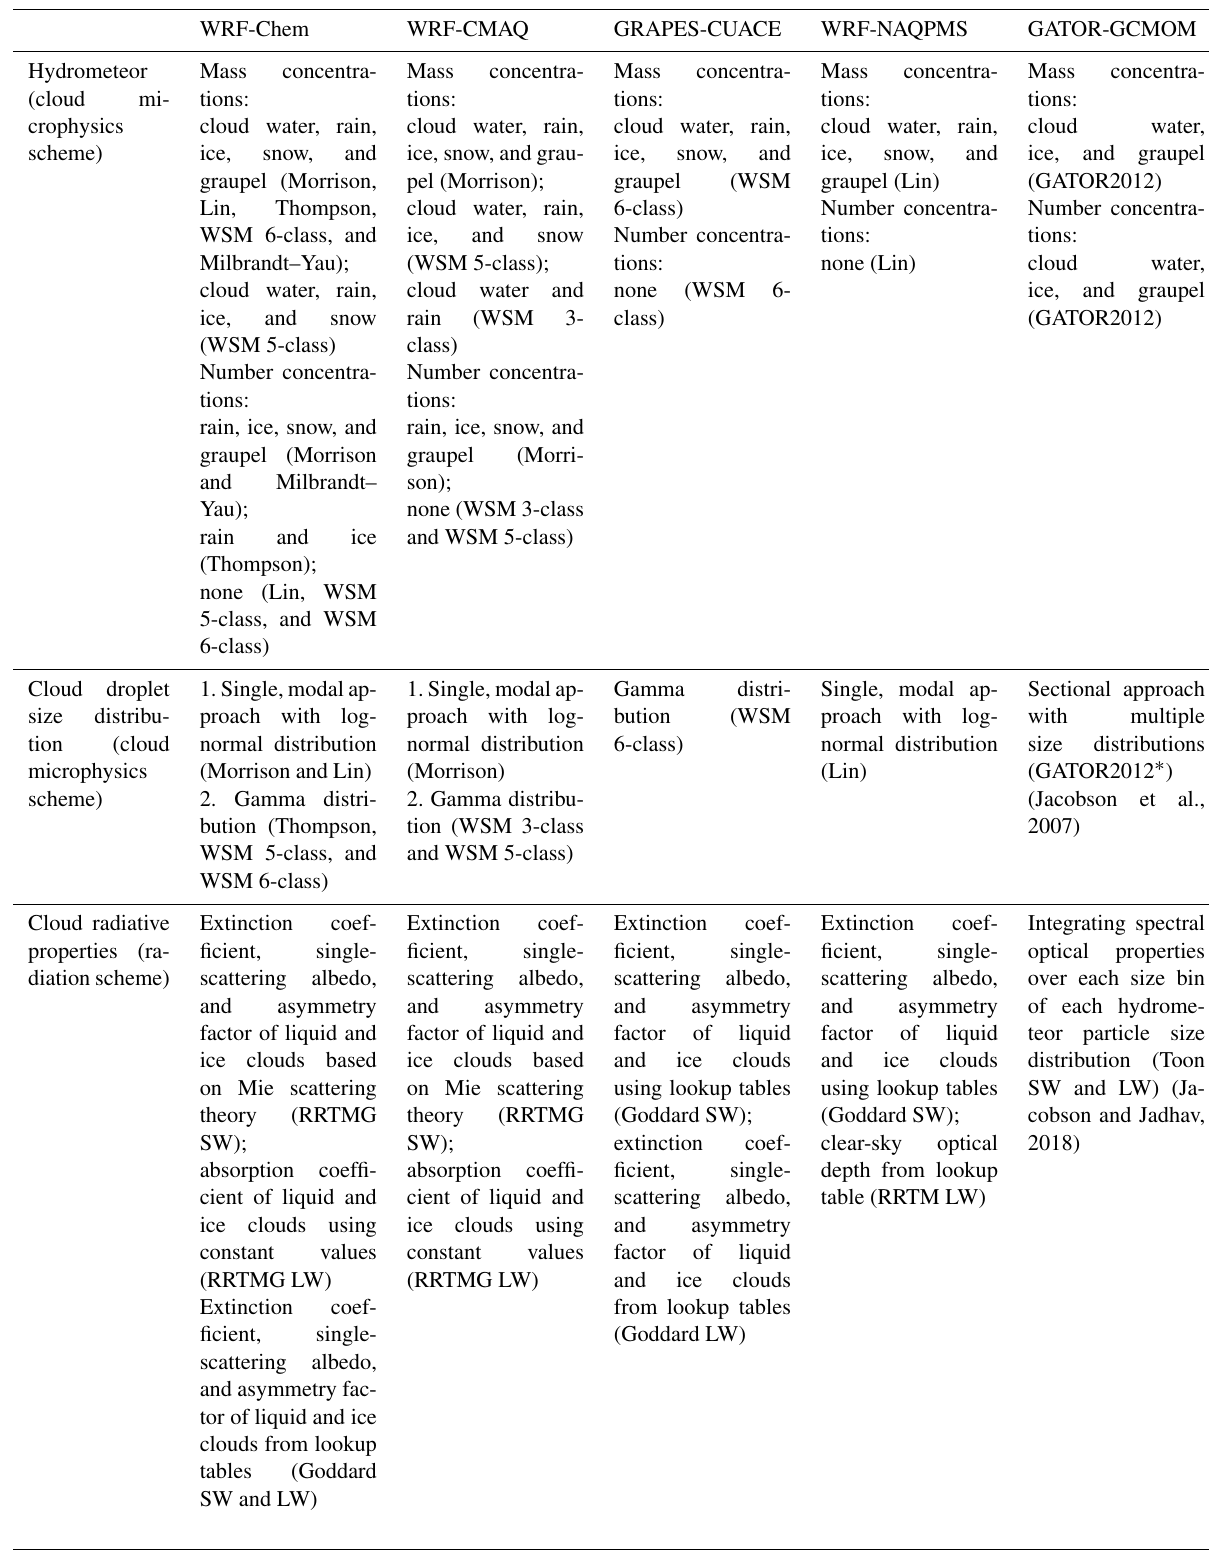
Table 3. Compilation of cloud properties and aerosol–cloud processes in two-way coupled models (WRF-Chem, WRF-CMAQ, GRAPES- CUACE, WRF-NAQPMS, and GATOR-GCMOM) applied in